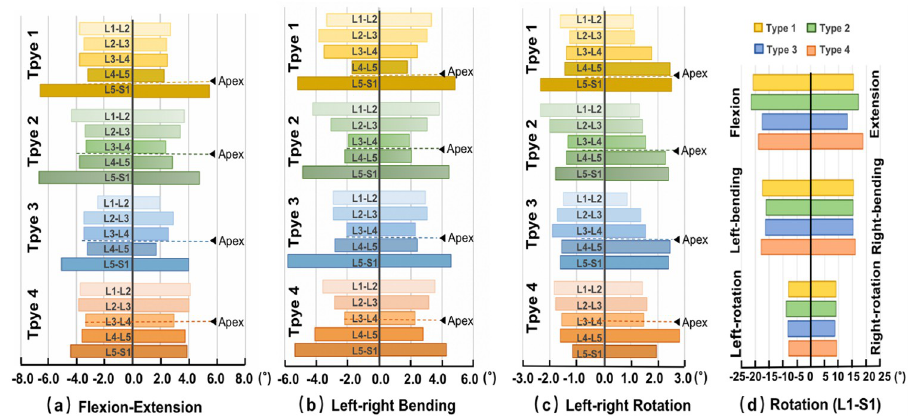
Fig 6. Rotation (˚) of each segment of four Roussouly type FE models (a) in flexion-extension (7Nm), (b) lateral bending (7Nm), (c) axial rotation (5Nm) and (d) the L1-S2 segments in the six loading conditions.